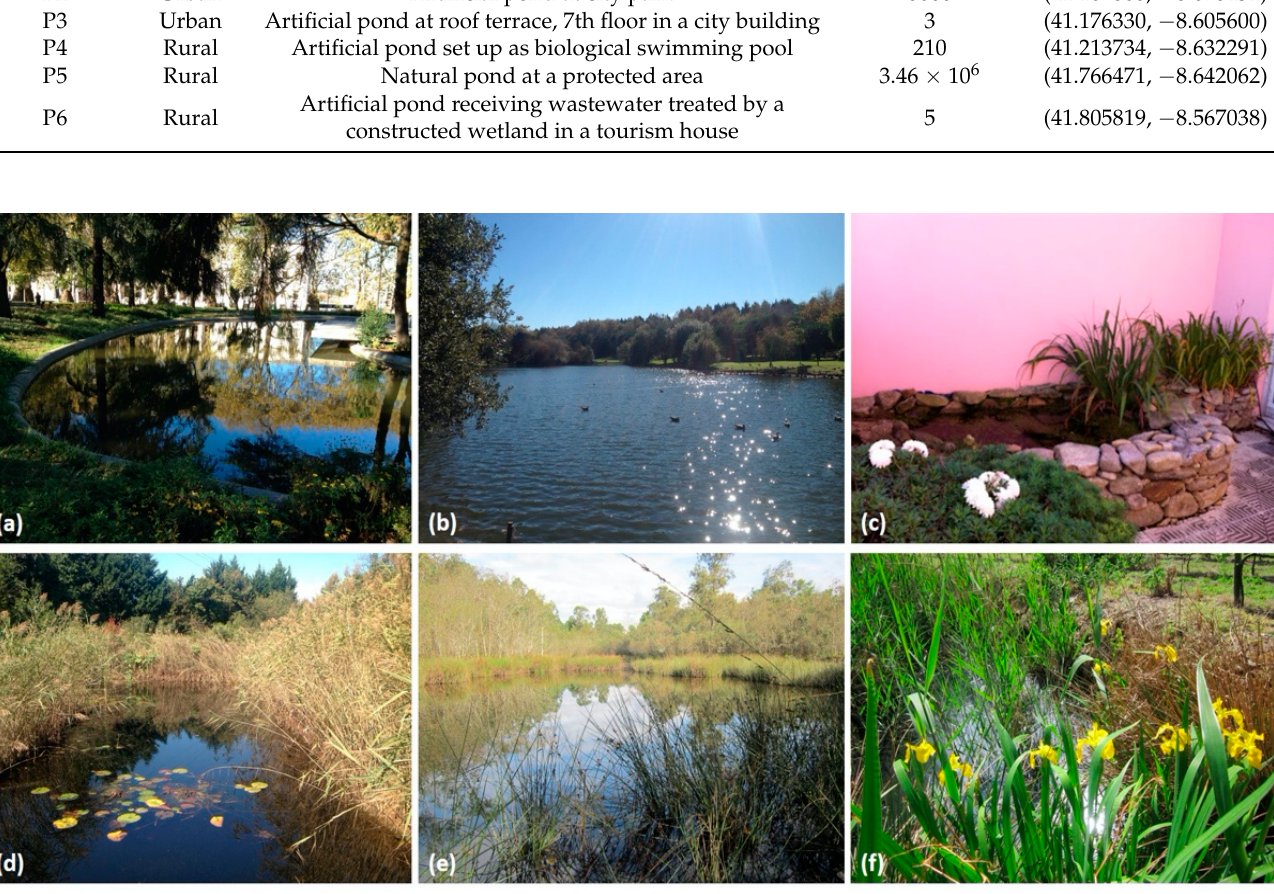
Figure 1. Water bodies sampling locations: ( a ) P1—artificial pond located in a city garden ( b ) P2—